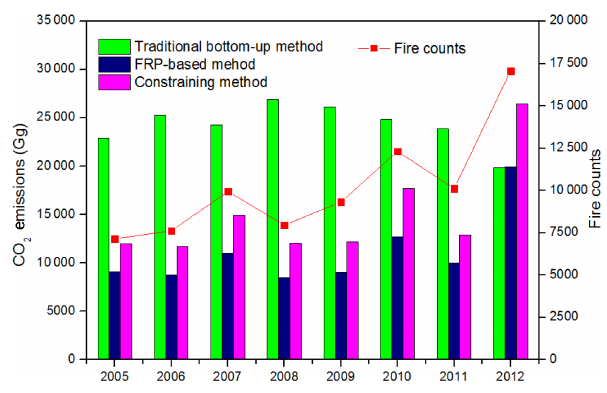
Figure 3. Fire counts and CO 2 emissions estimated with traditional bottom-up, FRP-based and constraining methods for YRD 2005–